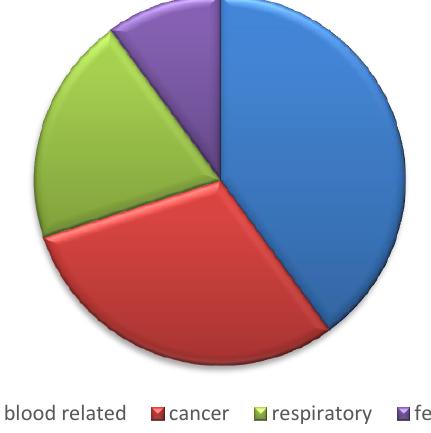
Figure 6: The pie chart above displayed the number of studies conducted among different type of non-hepatic disorder to observe the prevalence of TTV infection from 2001 to 2017. The chart was constructed by using Microsoft Excel version